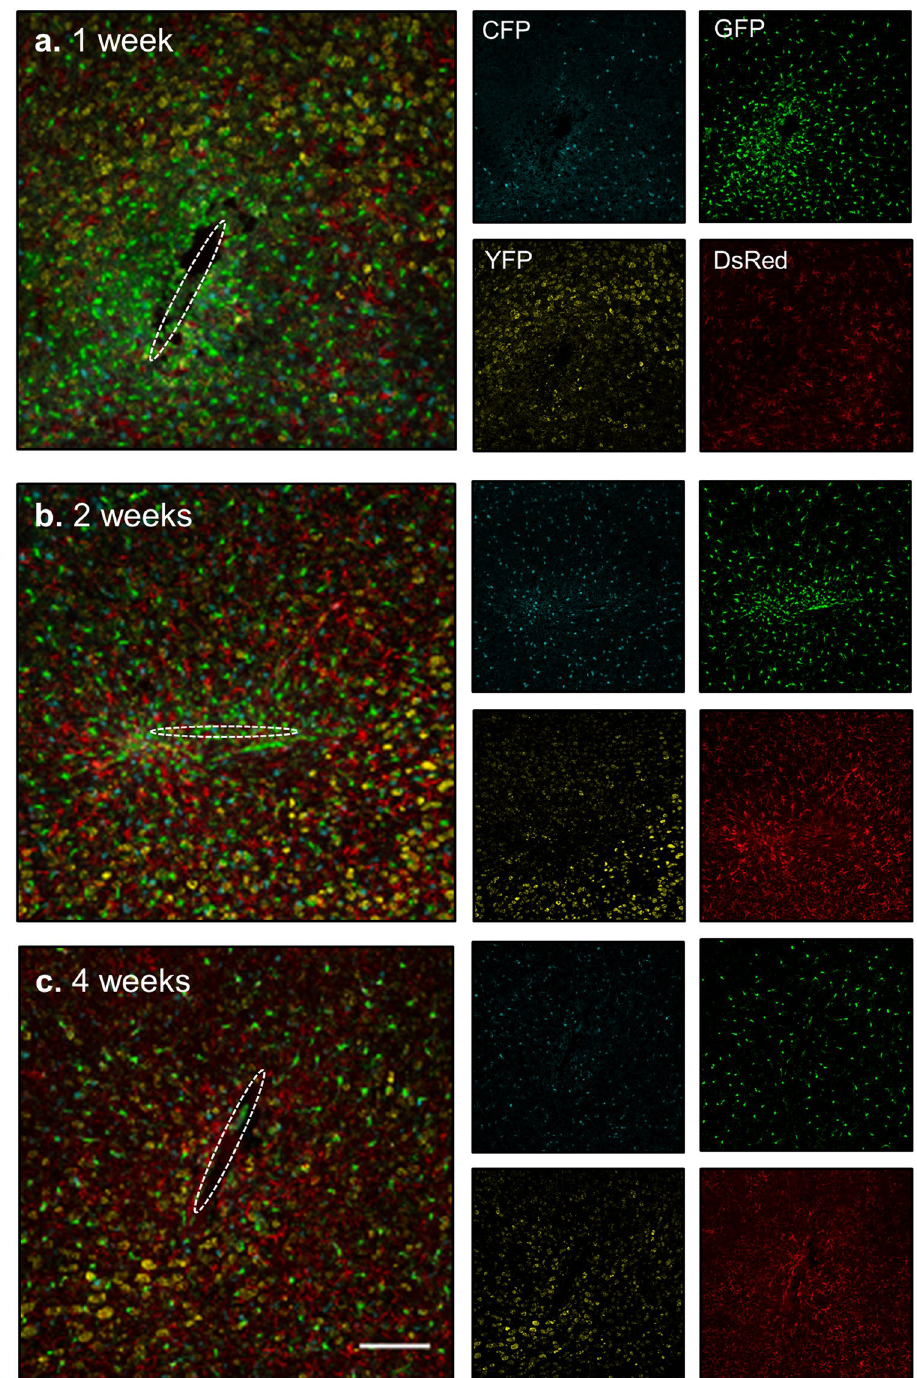
Figure 4. Cellular response to brain-implanted devices at multiple time points using PrismPlus mouse line. ( a–c ) Confocal images (merged) of cellular response to brain implanted devices at 1 week ( a ), 2 weeks ( b ) and 4 weeks ( c ) post implant. Dashed white ellipse represents the implant location. Merged images are separated into individual channels. Images are maximum projected intensity of 20 um thick sections and are approximately from the same depth (approximately 500 µ m deep) in the cortex. Images in Fig. 4(a–c) were captured and processed using same settings. Objective: Plan-Apochromat 20x/0.8; Laser power: 405 nm: 5%, 488 nm: 6% and 543 nm: 0.2%. Scale bar = 100 µ